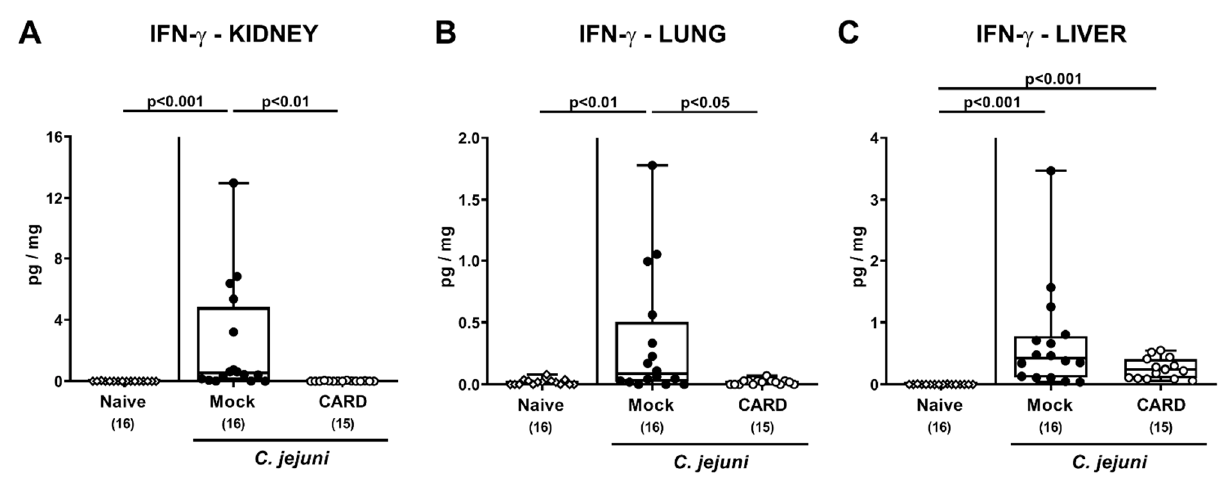
Figure 7. Extra-intestinal IFN- γ secretion following oral cardamom essential oil application to C. jejuni -infected microbiota- depleted IL-10 − / − mice. Microbiota-depleted IL-10 − / − mice were infected with C. jejuni strain 81–176 on days 0 and 1 by gavage and perorally challenged with cardamom essential oil (CARD; white circles) via the drinking water starting on day 2 post-infection, whereas mock control mice received vehicle (black circles). On day 6 post-infection, IFN- γ concentrations were measured in ex vivo biopsies derived from the ( A ) kidney, ( B ) lung, and ( C ) liver. Naive mice (open diamonds) served as untreated and uninfected controls. The box plots indicating the 75th and the 25th percentiles of the median (black bar within box), the total range, the levels of significance ( p values) as calculated with the Kruskal–Wallis test and Dunn’s post-correction, and the number of analyzed mice (in parentheses) are shown. Data were pooled from four independent experiments.